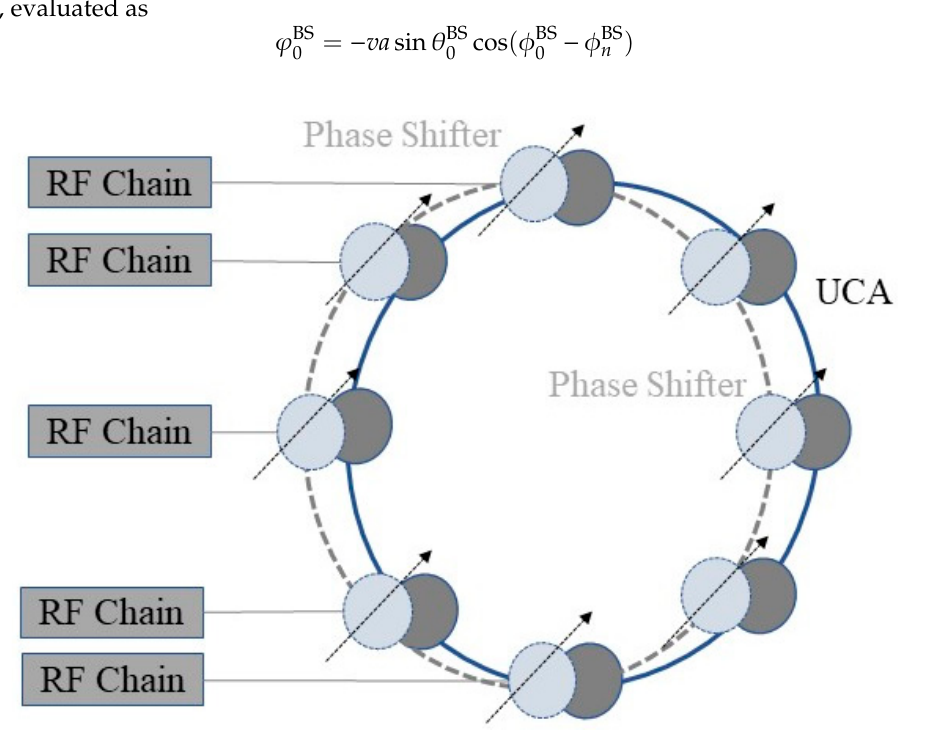
Figure 2. Digital beamformer at the BS.